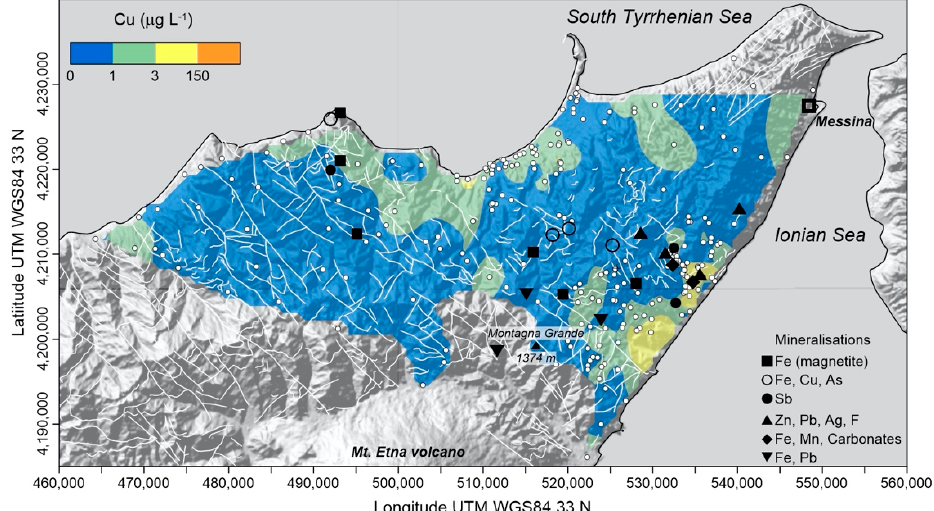
Figure 11. Concentration distribution map of Cu, reporting locations of sampling points (with indication of those exceeding the related MACs) and main mineral deposits; tectonic lineaments (white lines) are also illustrated.